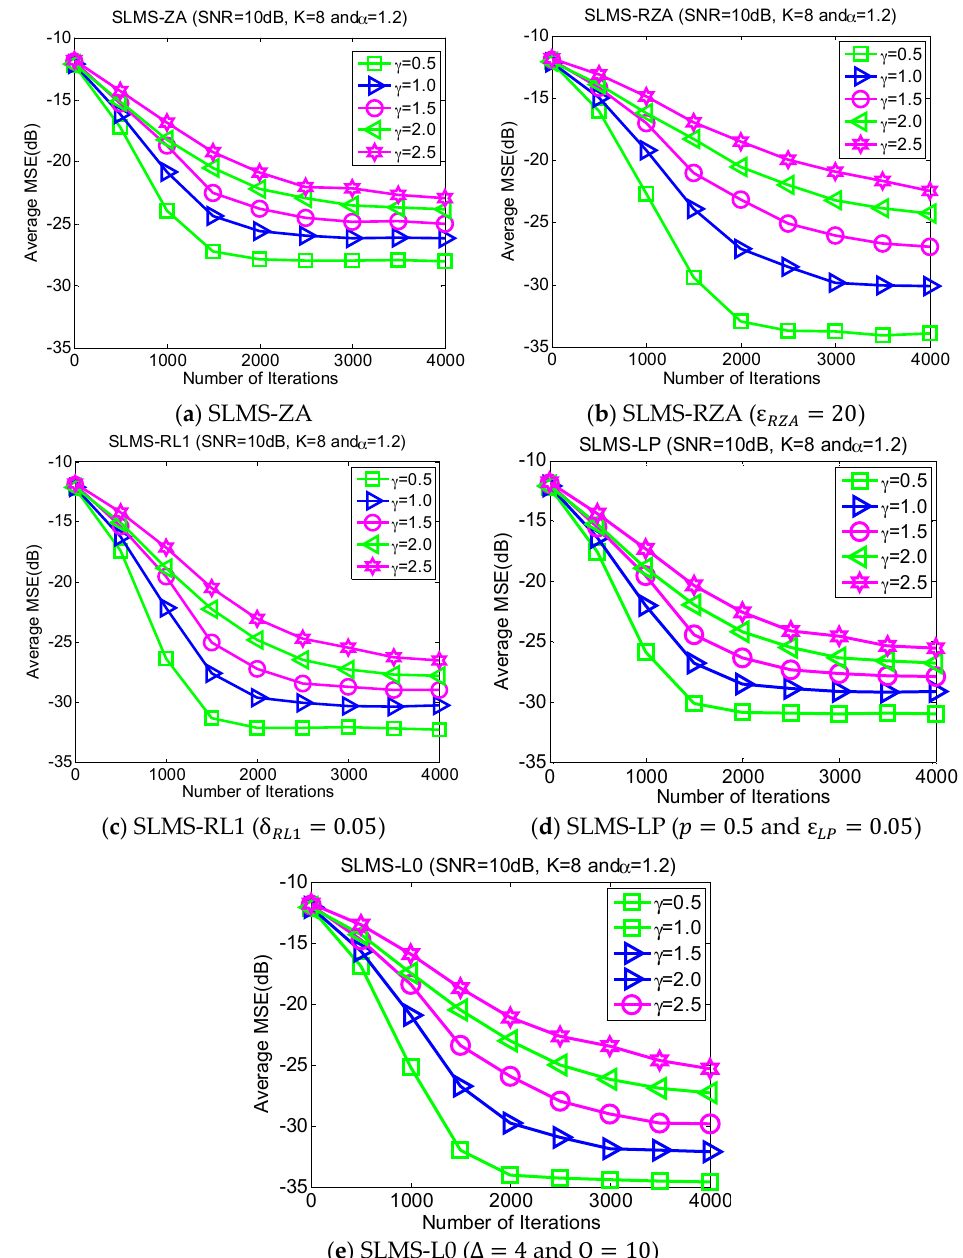
Figure 5. Monte Carlo based MSE curves averaging over 1000 runs with respect to different dispersion parameters γ ∈ {0.5,1.0,1.5,2.0,2.5} , in scenarios of characteristic exponent α = 1.2 , channel length N = 128, channel sparsity K = 8, and SNR = 10